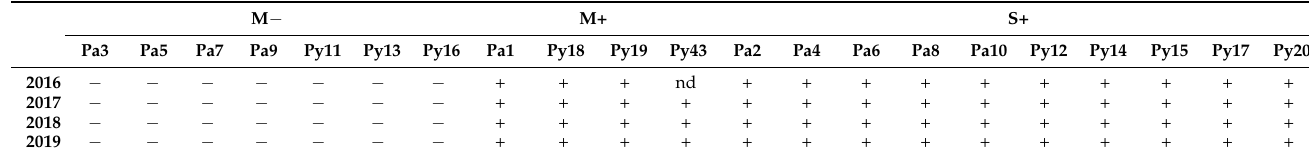
Table 1. Presence (+) or absence ( − ) of grapevine fanleaf virus (GFLV) in leaves of individual ‘Chardonnay’ vines collected in spring from 2016 to 2019, as determined by DAS-ELISA. Vines were classified into three categories: M − (mild symptomatic, GFLV-free vines), M+ (mild symptomatic, GFLV-infected vines) and S+ (severe symptomatic, GFLV-infected vines). The presence/absence of GFLV in vine Py43 was only tested starting in 2017 as this plant was only identified in autumn 2016 (nd: not determined).